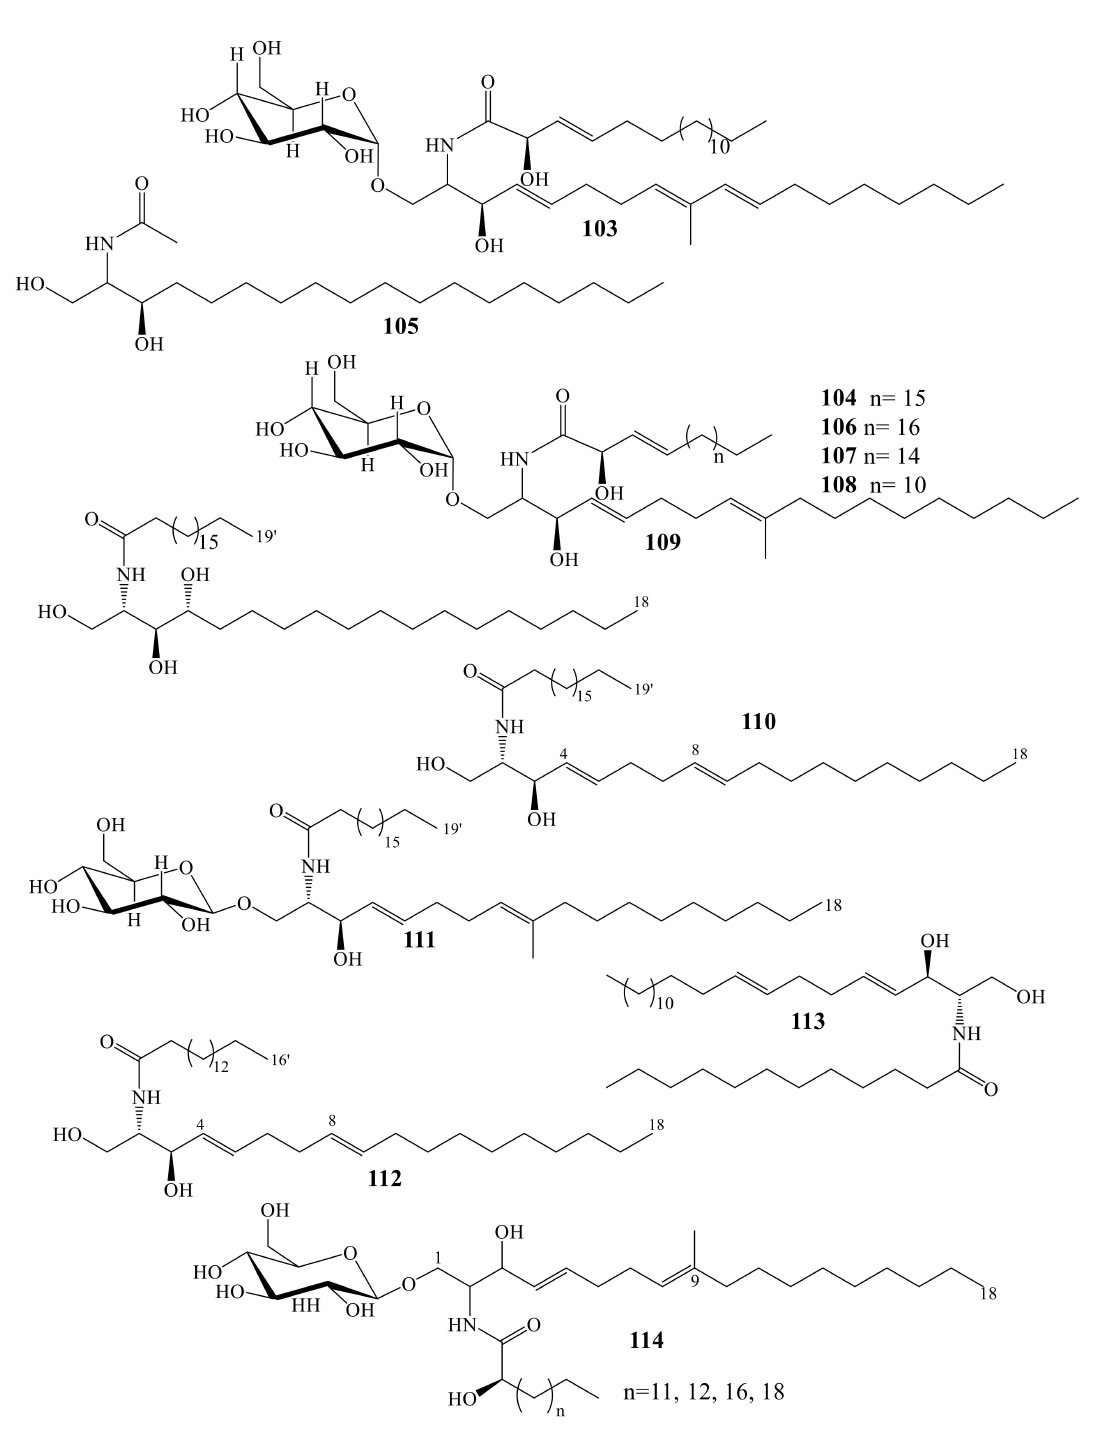
Figure 9. Ceramides and Cerebrosides ( 103 – 114